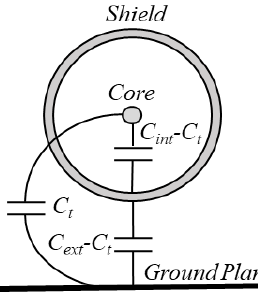
FIGURE 7. Effective capacitance model of the coaxial cable over a ground